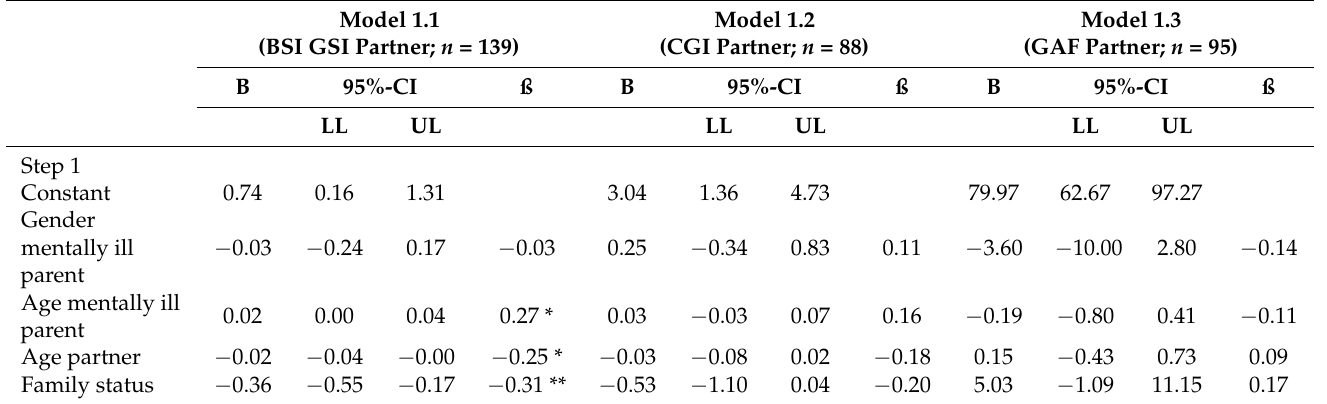
Table 3. Hierarchical regression analyses predicting partners’ symptomatology using BSI, CGI, and GAF